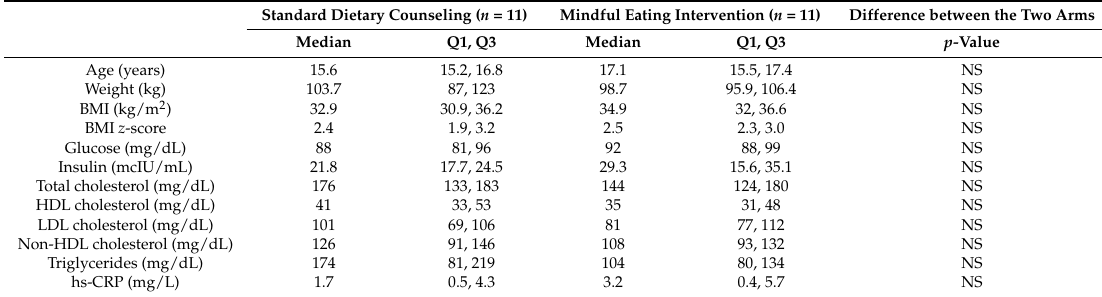
Figure 1. Study flow. Table 1. Anthropometric and laboratory characteristics of study participants.